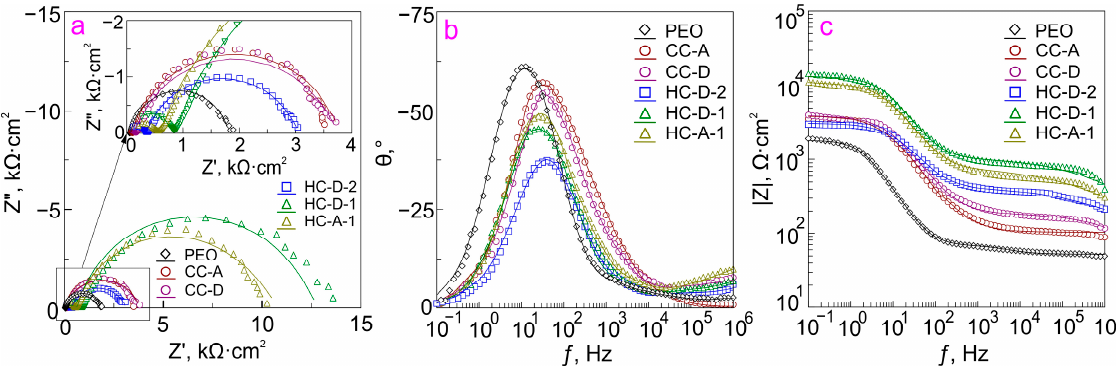
Figure 10. Impedance spectra Nyquist ( a ) and Bode plots ( b , c ) for the studied samples acquired after 22 h of exposure to 3.5 wt.% NaCl